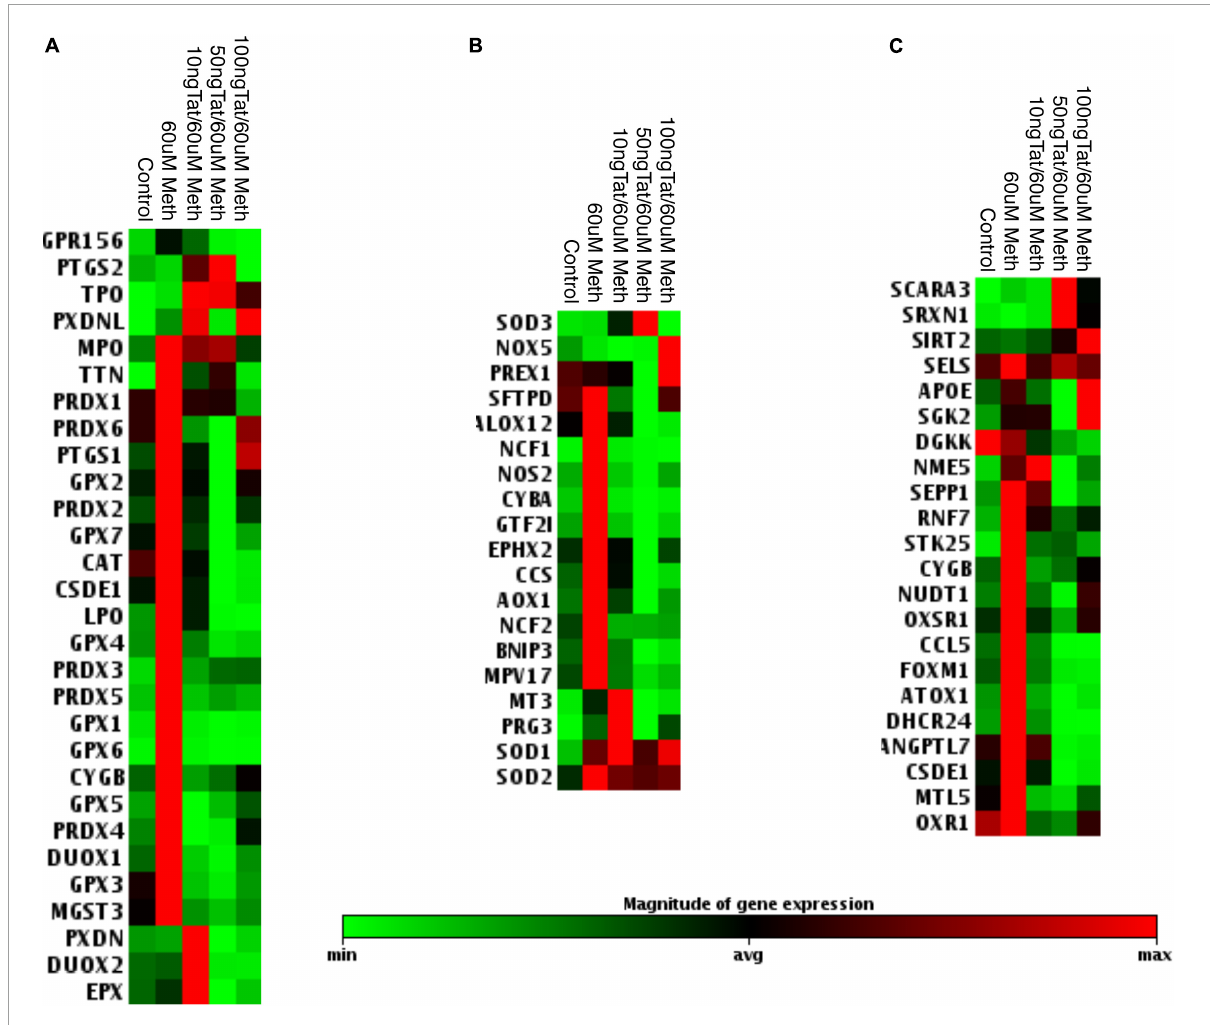
FIGURE2 Effects of Tat on Meth-induced changes in the oxidative stress response in THP1 macrophages. The heat map shows the average transcription of oxidative stress genes 2 h after the stimulation with Meth alone and with Meth + HIV Tat peptide at the doses of 10, 50, and 100 ng/ml. Map shows significantly affected genes as per ANOVA p < 0.05. The genes were normalized by average of 3 independent experiments in duplicate and were organized by function categories and expression clustering. (A) Antioxidant pathways; (B) Reactive Oxygen Species Metabolism pathway genes; (C) Oxidative Stress Response Genes. Gene expression was measured using RT2 Profiler PCR array focused on Human Oxidative